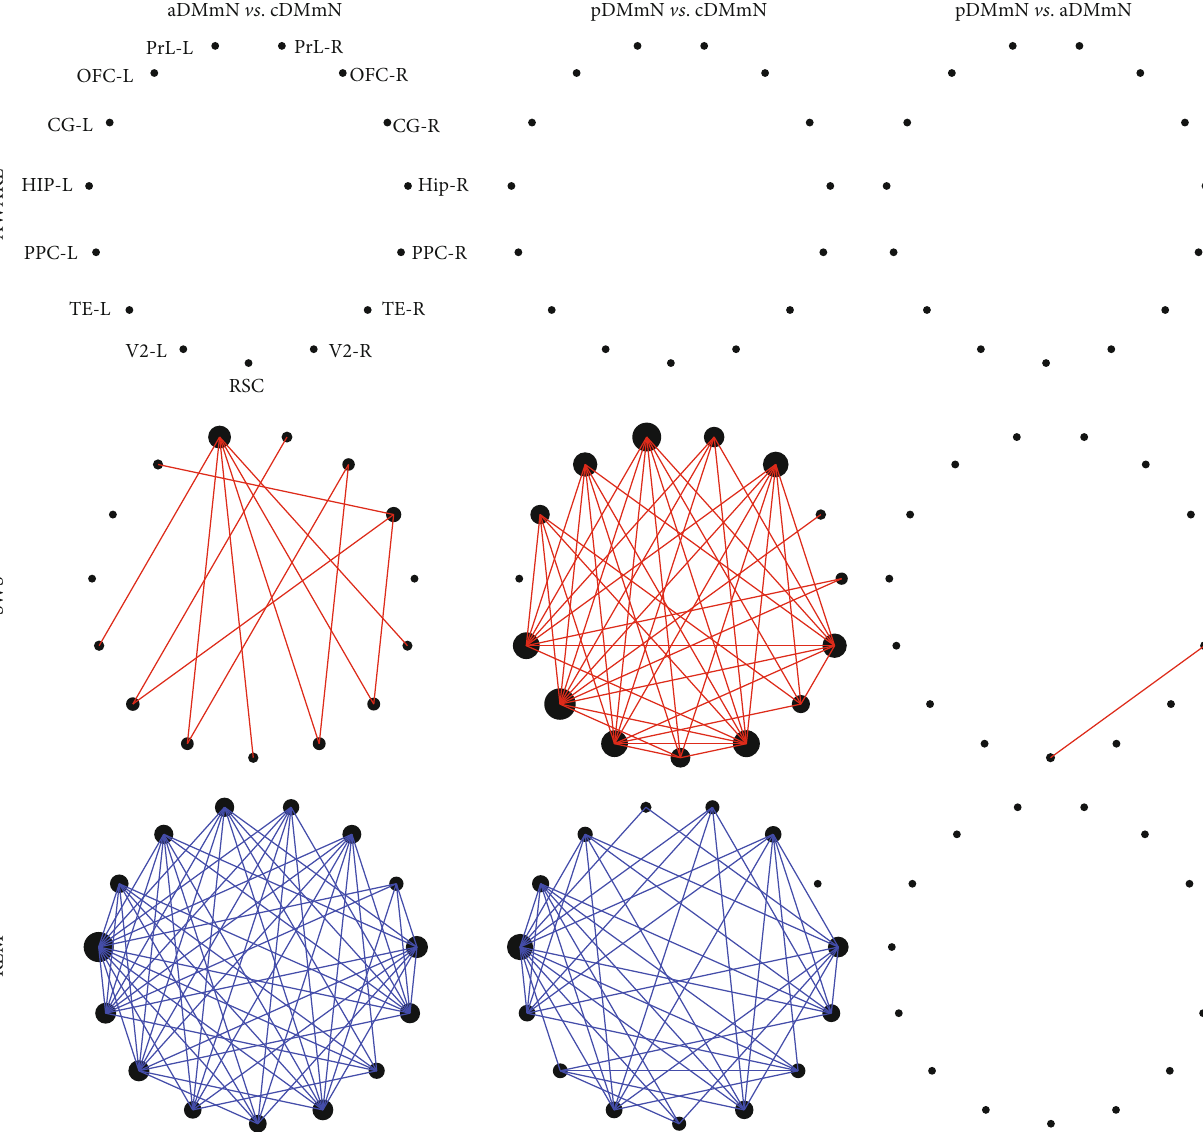
Figure 3: Comparisons among the three CAMP networks in di ff erent states of consciousness. The red lines indicate signi fi cantly increased FC with p < 0 : 0002 (FWE correction). The blue lines indicate signi fi cantly decreased FC with p < 0 : 0002 (FWE